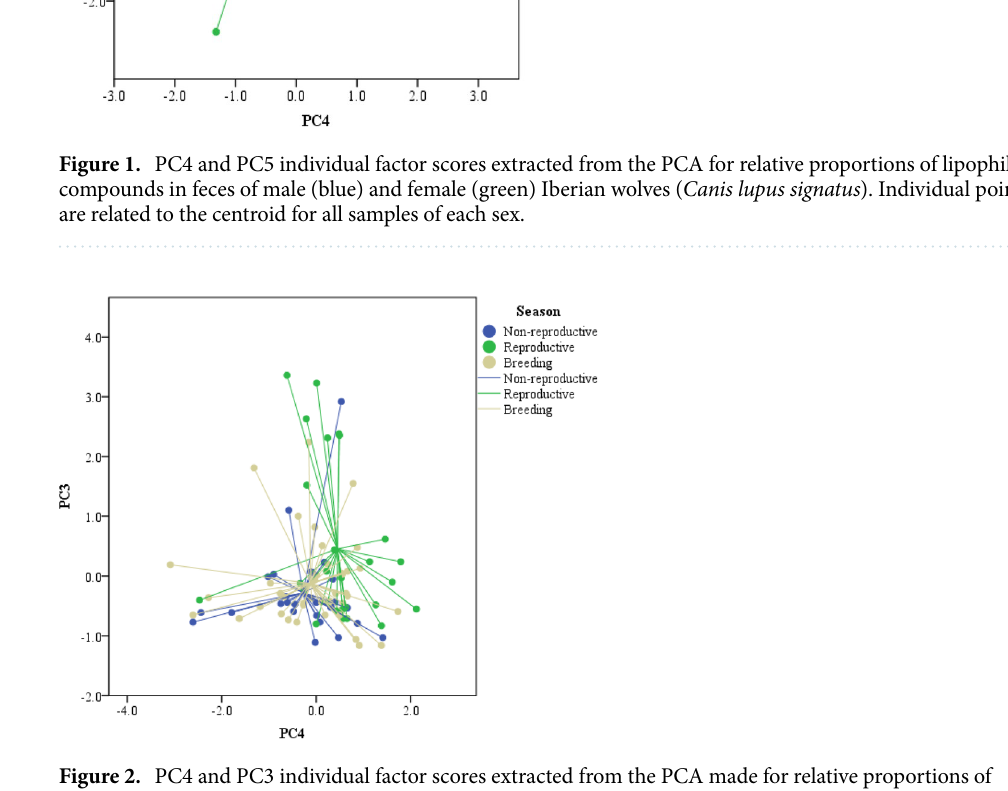
Figure 2. PC4 and PC3 individual factor scores extracted from the PCA made for relative proportions of lipophilic compounds in feces of adult Iberian wolves ( Canis lupus signatus ) depending on the reproductive status of individuals: non-reproductive (blue), reproductive (green) or breeding (grey). Individual points are related to the centroid for all samples of each reproductive